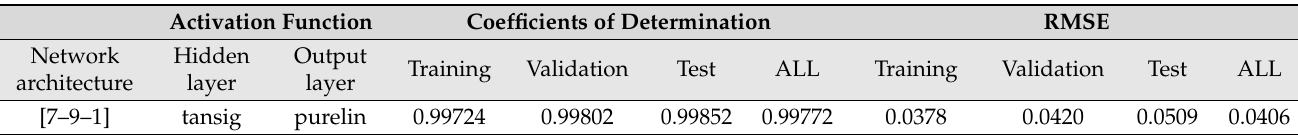
Figure 9. Schematic representation of the ANN model. Table 1. Performances of the ANN architecture.